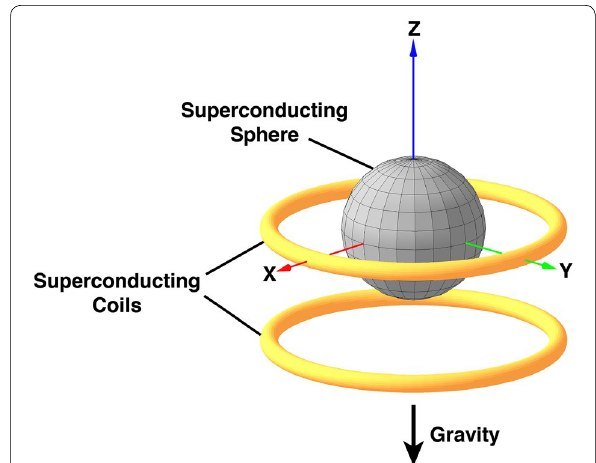
Fig. 1 Superconducting sphere and coils in the gravity sensor of the superconducting gravimeter